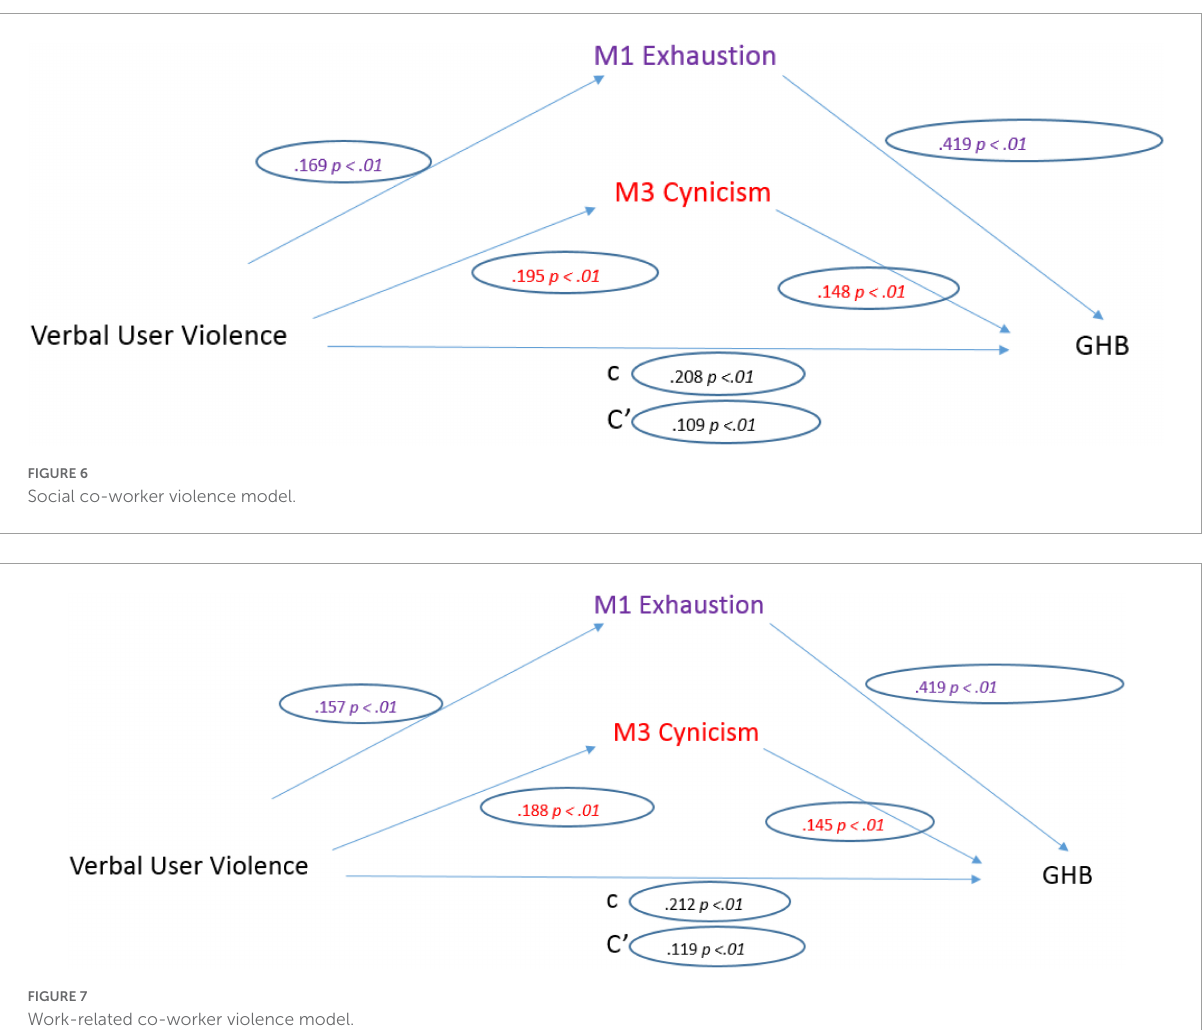
FIGURE7 Work-related co-worker violence